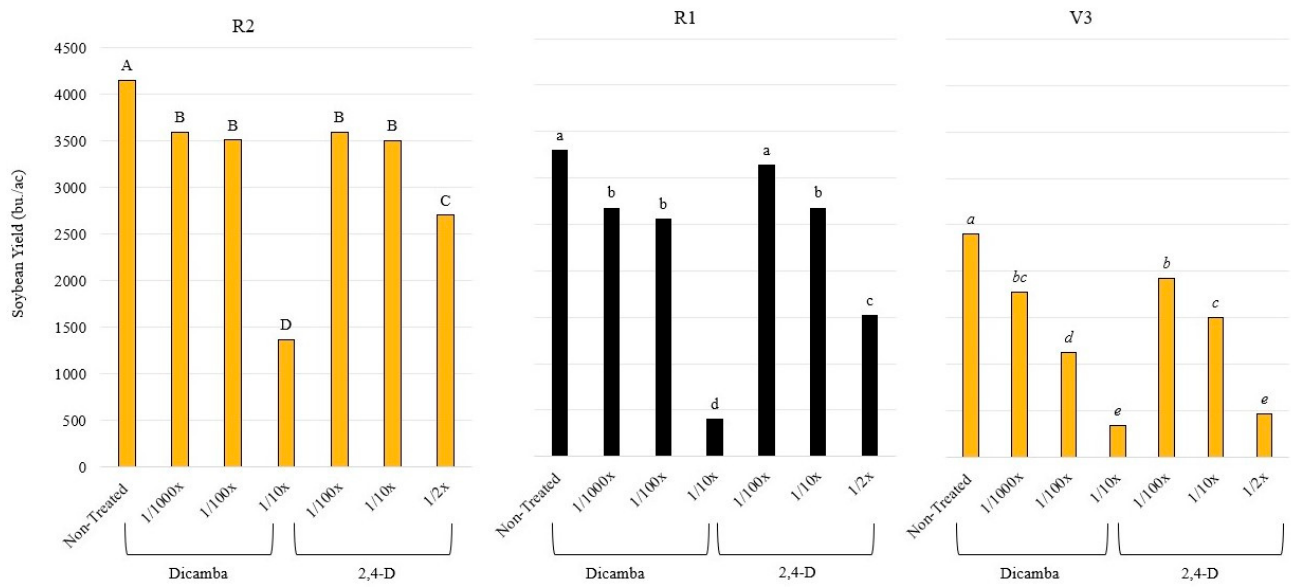
Figure 3. The influence of herbicide treatment and soybean growth stage at the time of treatment on soybean grain yield. Bars followed by the same letter are not significantly different p ≤ 0.05 and means are separated within each grouped bar graph.